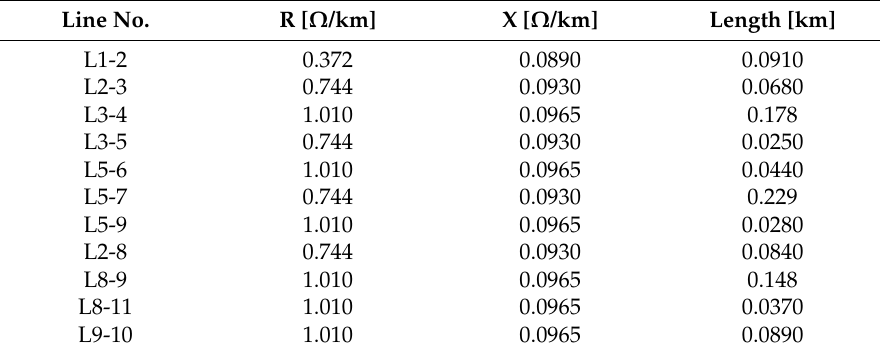
Table A1. Line data of the distribution grid of the ESUSCON microgrid. Line